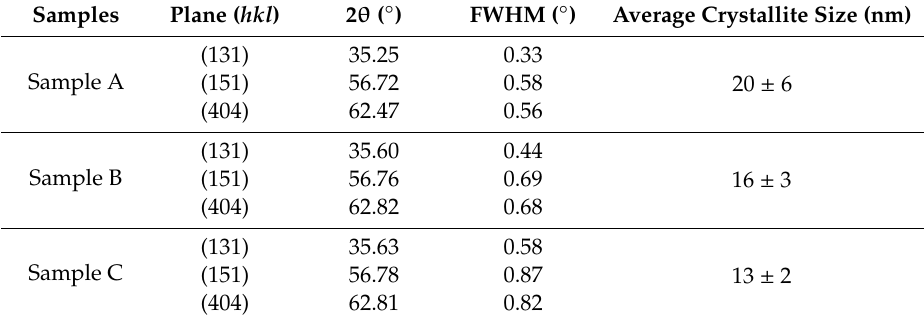
Table 2. Average crystallite size and XRD peak broadening data of each sample. FWHM: full width at half maximum.